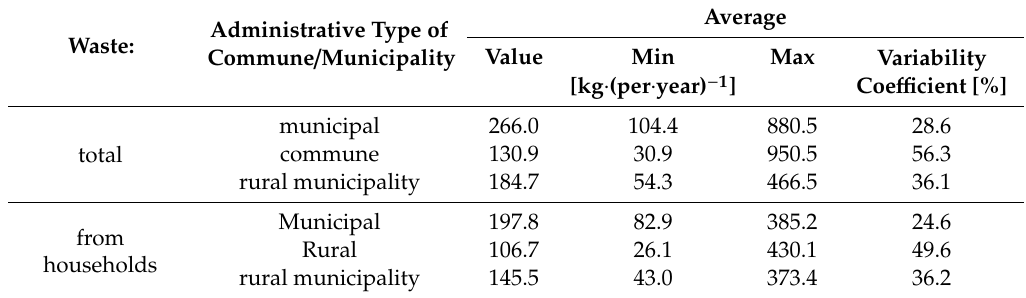
Table 4. Impact of the administrative-type commune on the value of unit waste accumulation